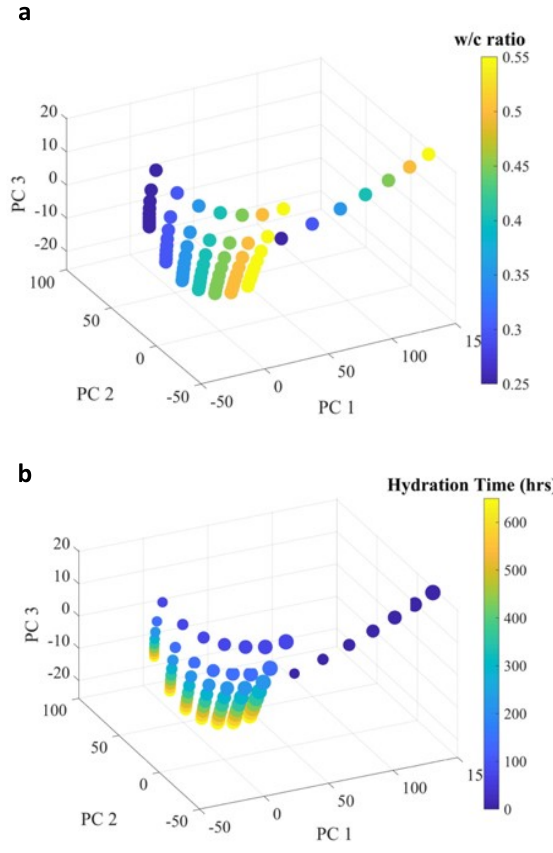
Figure 6 . 3D visualization of the first three principal components to distinguish between process parameters (a) water ‐ to ‐ cement ratio and (b) total hydration time